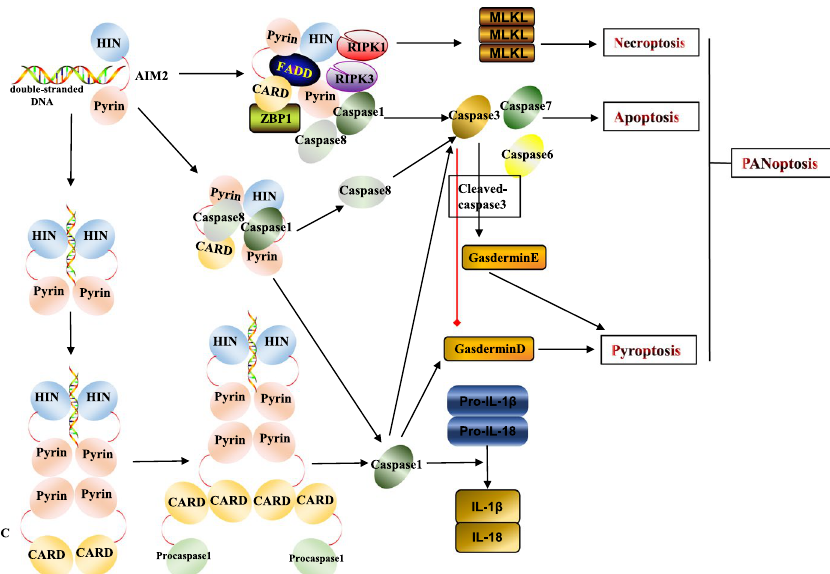
Fig. 1 Absent in melanoma 2 (AIM2)-mediated pyroptosis and PANoptosis. AIM2 assembles into the AIM2 inflammasome by recognizing double-stranded DNA and subsequently oligomerizing and binding ASC and procaspase-1. The cleavage of procaspase-1 promotes the maturation of caspase-1. Caspase-1, in turn, promotes the maturation of pro-1β and pro-18 and cleaves gasdermin D (GSDMD) to promote the disruption of cell membranes and the release of IL-1β and IL-18. AIM2 also binds ASC, FADD, RIPK1, RIPK3, caspase-1, caspase-8, and ZBP1 to assemble the PANoptosome and activate downstream effectors, including the apoptosis effectors (caspase-3, -6, and -7), pyroptosis effector (GSDMD), and necroptosis effector (MLKL), thereby promoting PANoptosis. In addition, AIM2 binds caspase-8, caspase-1, and ASC to form a complex, activating caspase-8 and caspase-1, cleaving downstream caspase-3, and ultimately promoting apoptosis. Cleaved caspase-3 inhibits gasdermin D and mediates pyroptosis through gasdermin E. Caspase-1 also activates pyroptosis via